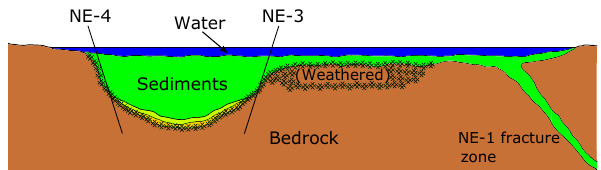
Figure 11. Conceptual model based on the geophysical results and known geologic interpretations of the test site at Äspö. The hash signature at the bedrock interface indicates a higher